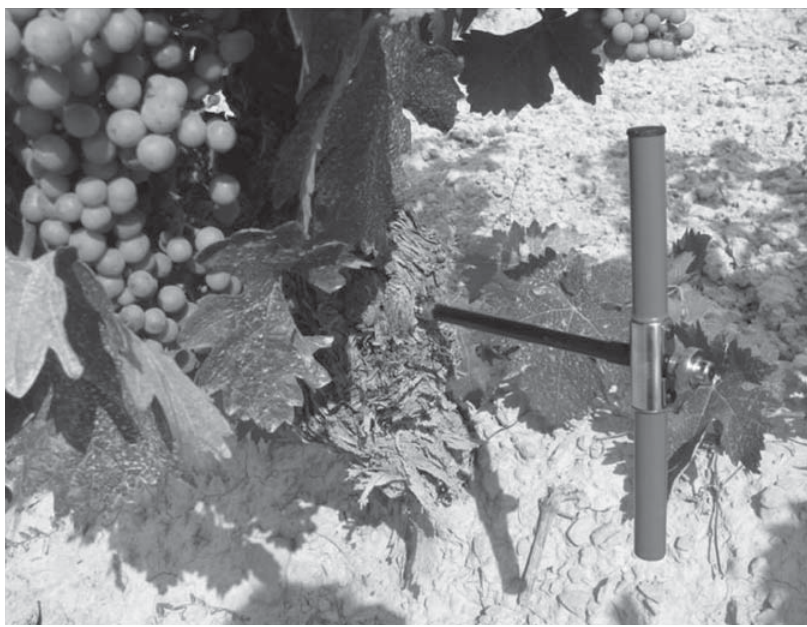
Fig. 1. Sampling of grapevine wood by means of an increment